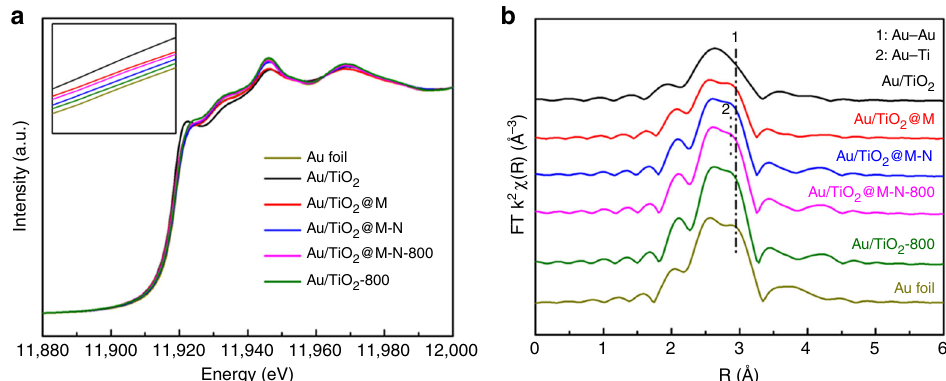
Fig. 4 X-ray absorption spectroscopy analysis. a Normalized XANES spectra at the Au L III -edge of Au foil, Au/TiO 2 , Au/TiO 2 @M, Au/TiO 2 @M-N, Au/ TiO 2 @M-N-800, Au/TiO 2 -800. b Fourier transform of k 3 -weighted EXAFS spectra of Au foil, Au/TiO 2 , Au/TiO 2 @M, Au/TiO 2 @M-N, Au/TiO 2 @M-N- 800, and Au/TiO 2